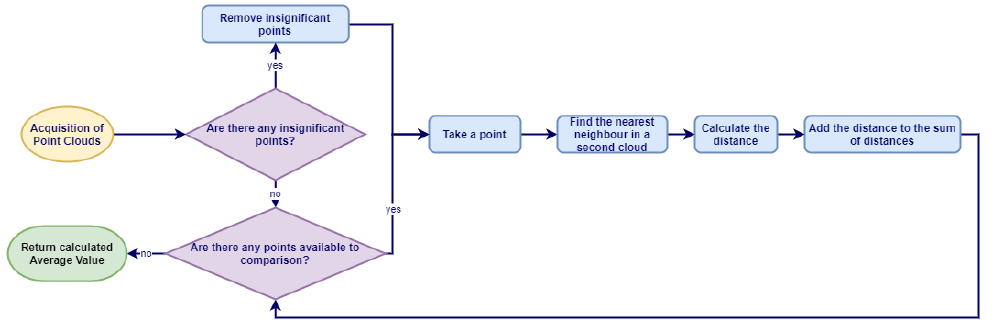
Figure 5. The algorithm used to evaluate the distance between the point